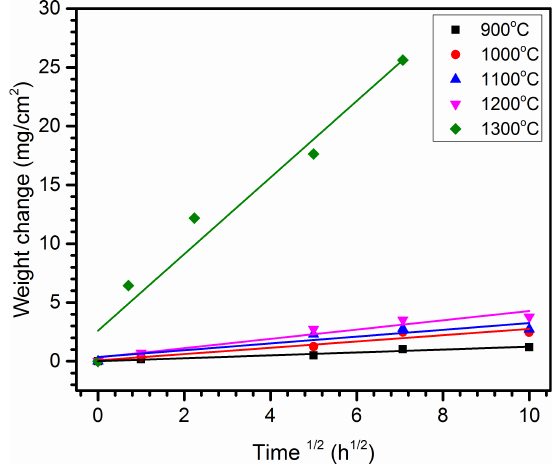
Figure 1: BSE microstructure of the Mo-40Ti-30Si system containing (Ti, Mo) Si matrix and (Ti, Mo) Si precipitates. Figure 2: Weight change data indicating parabolic oxidation be- 5 3 3